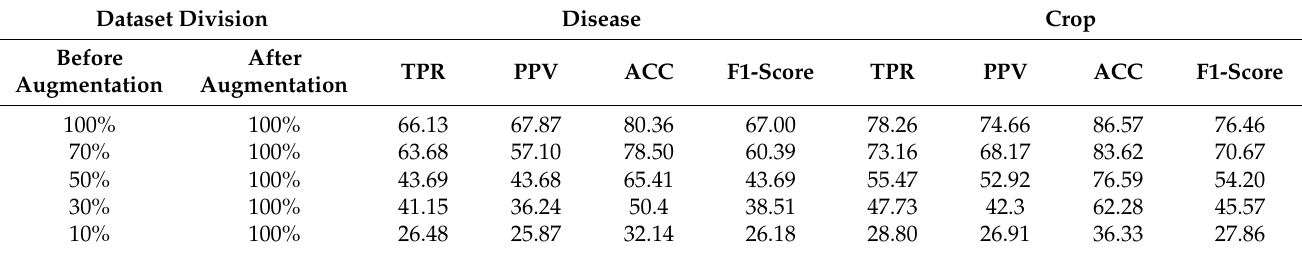
Table 26. Comparison of accuracies achieved by the proposed PI-CNN in the original and PI-GAN- augmented datasets. The accuracies were achieved in the PlantDoc dataset (unit: %).